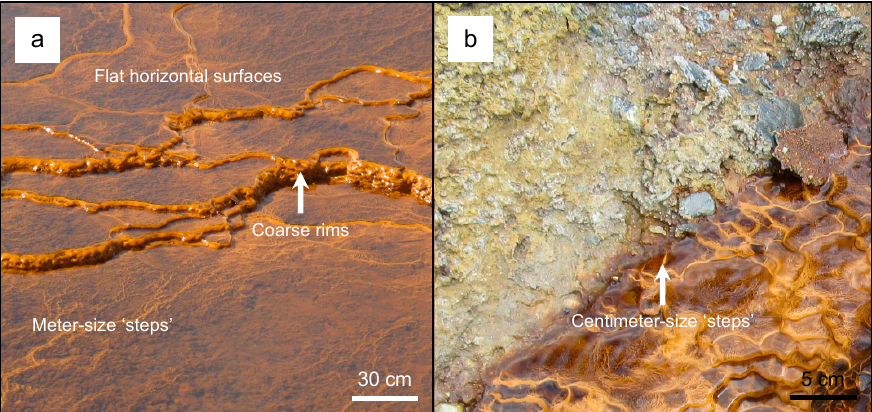
Figure 1. A photograph of meter-sized terraced iron formations (TIFs) ( a ) and centimeter-sized TIFs ( b ) that formed within the Lousal (Portugal) and Tharsis (Spain) open pit mines, respectively. Note that the coarse rims and centimeter-size steps that lobate the structures (arrows).